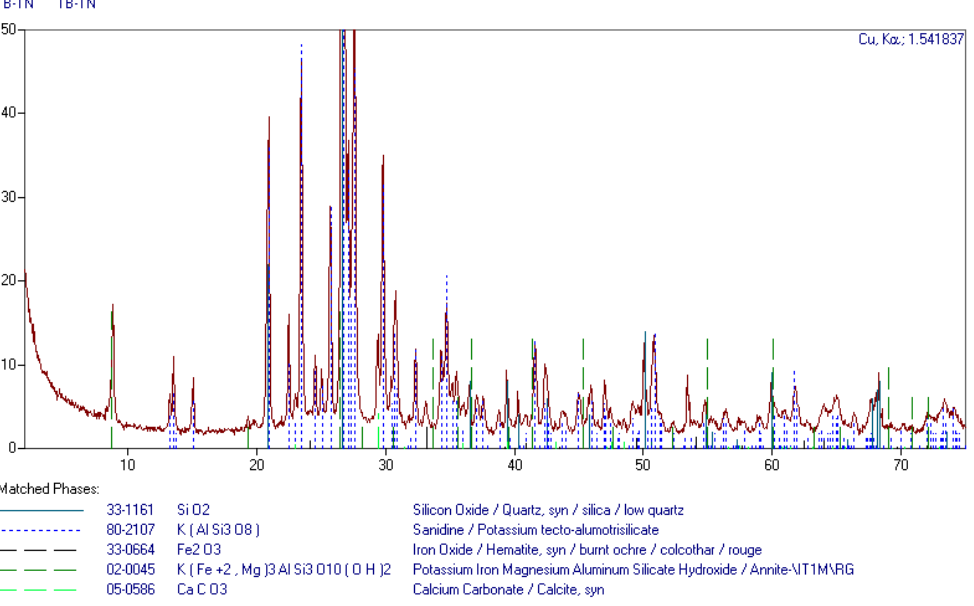
Figure 1. Results of the XRD analysis of the tuff under delivery condition: identified phases [33].